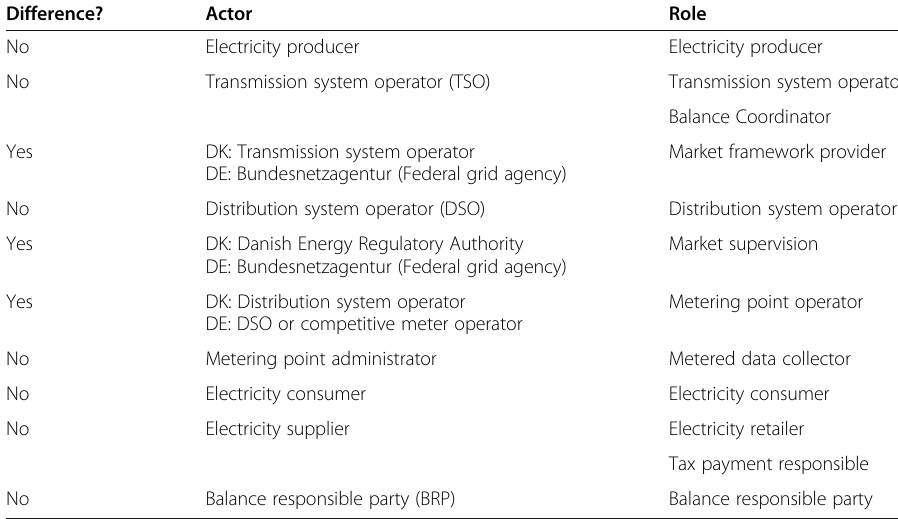
(Bundesnetzagentur 2016; Energinet